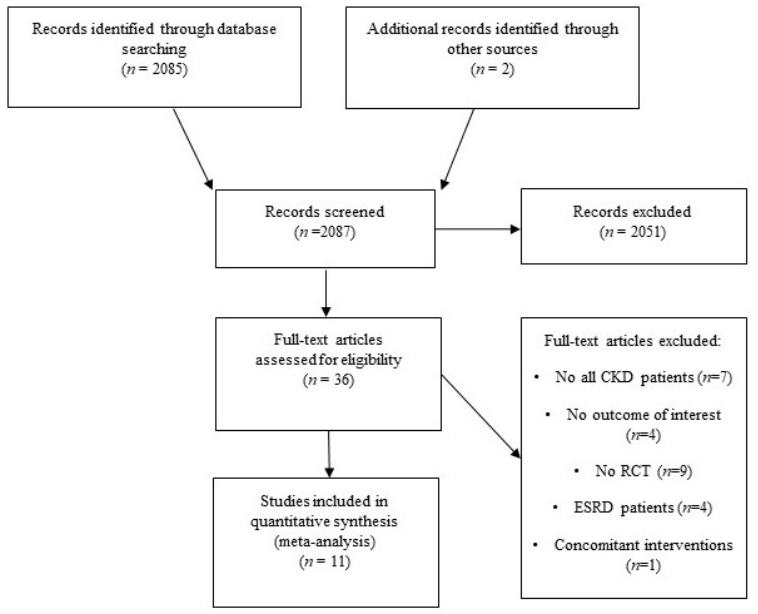
Figure 1. Flow-chart of study selection.